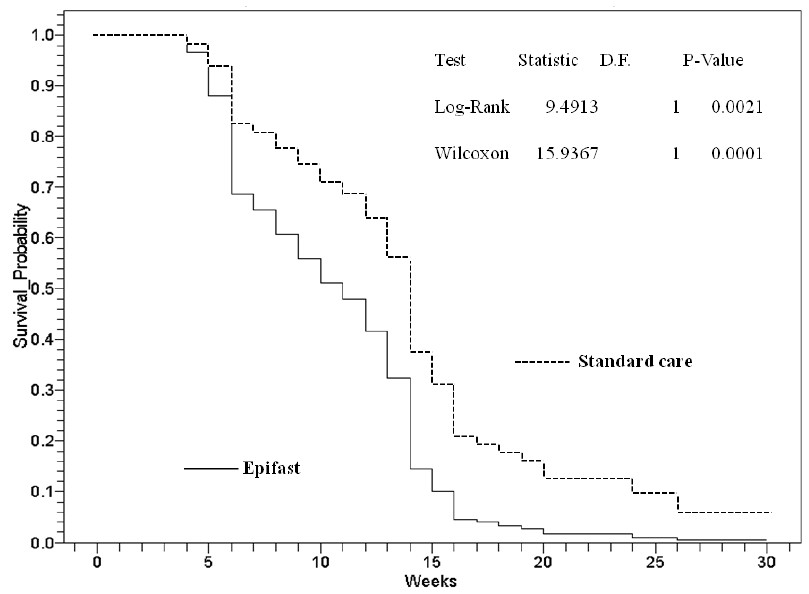
Figure 2. Kaplan–Meier survival probability analysis of wound healing failure by weeks for study groups with a mean follow-up period of 365 days. Survivors were non-healing patients.